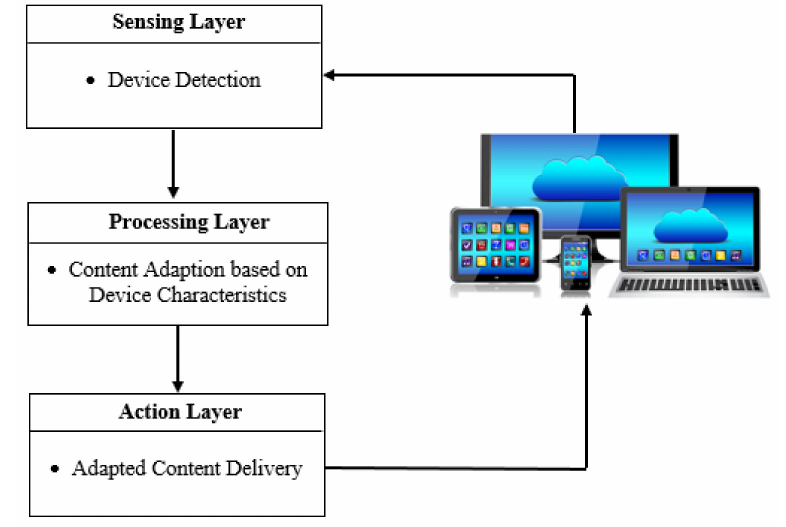
Figure 20. Device-aware system